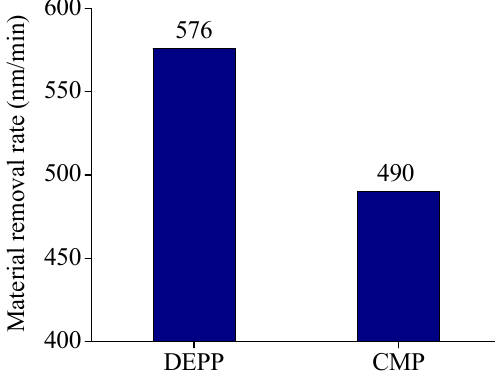
Figure 8. Comparison of MRR between two polishing methods.